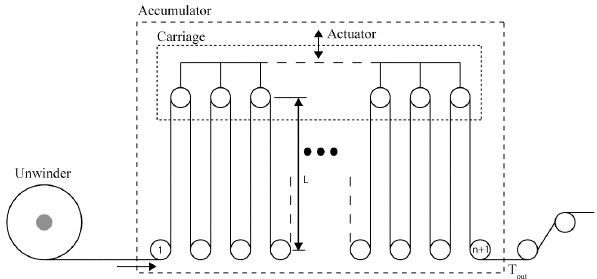
Fig. 1. Sketch of an industrial